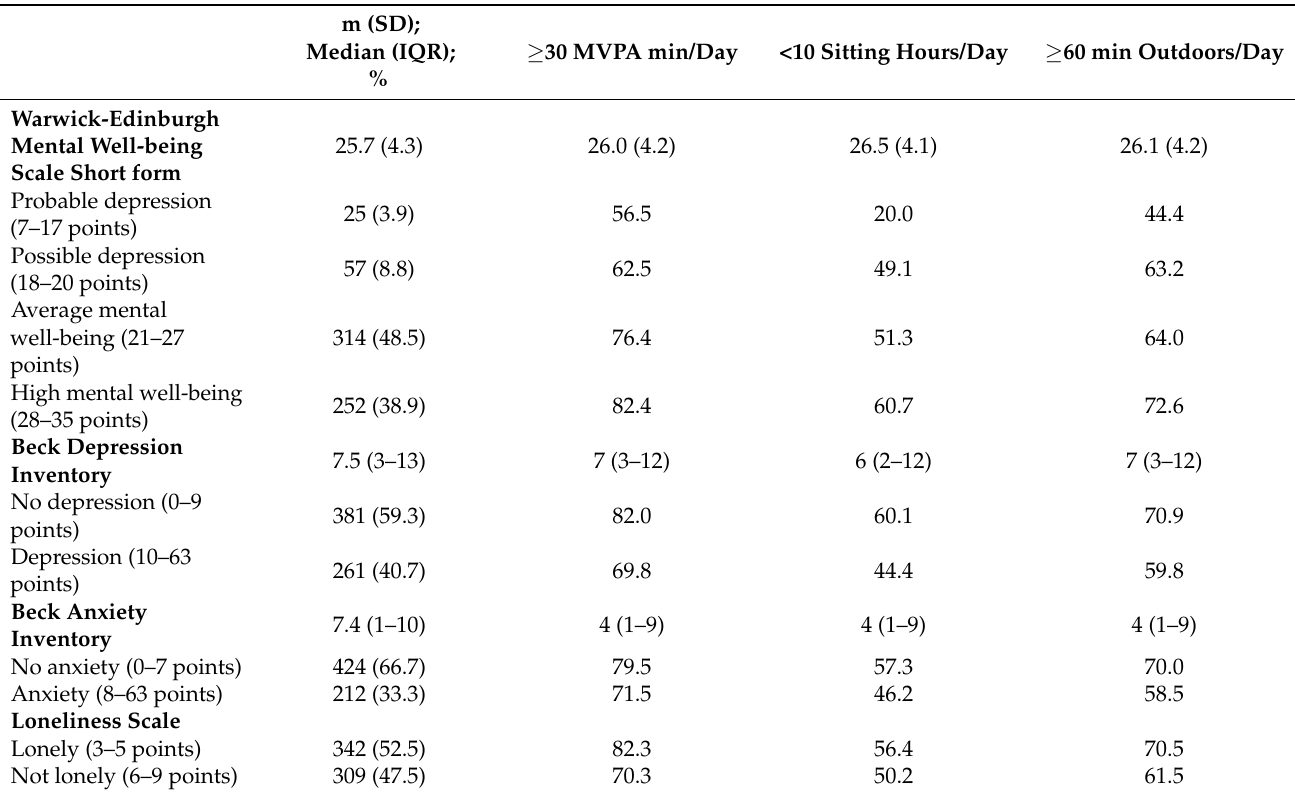
Table 3. Psychological